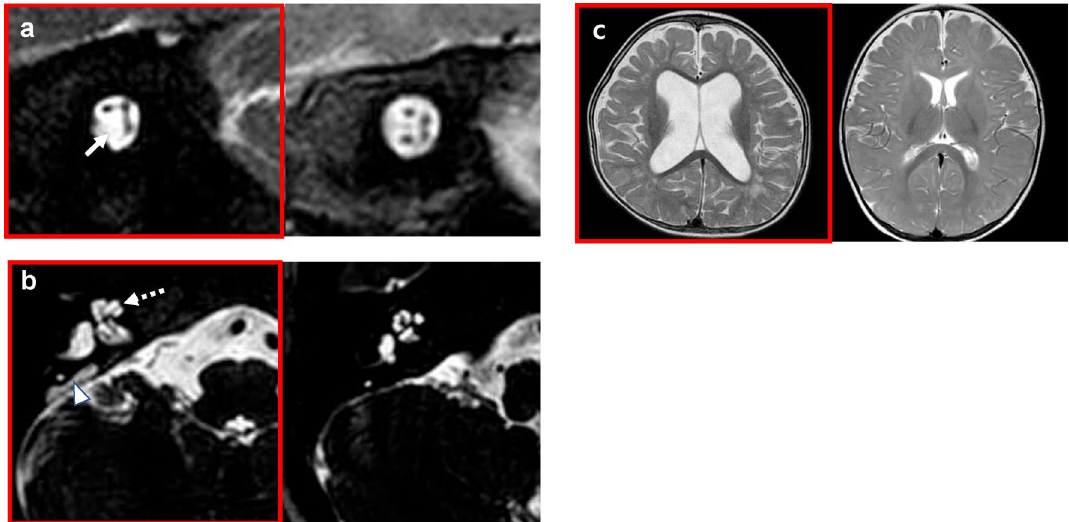
Figure 1. Three major abnormalities related to pediatric SP-SNHL as seen in IAC-MRI. Images on the left side show abnormal findings, while normal findings are on the right. ( a ) Cochlear nerve deficiency: Cochlear nerve is not observed in the internal auditory canal (arrow). ( b ) Enlarged vestibular aqueduct with incomplete partition type 2: Vestibular aqueduct is enlarged and conical in shape (arrowhead), and the interscalar septum is not present (dotted arrow). ( c ) Periventricular leukomalacia: Ventriculomegaly with irregular margins of the bodies of the lateral ventricles and loss of periventricular white matter are